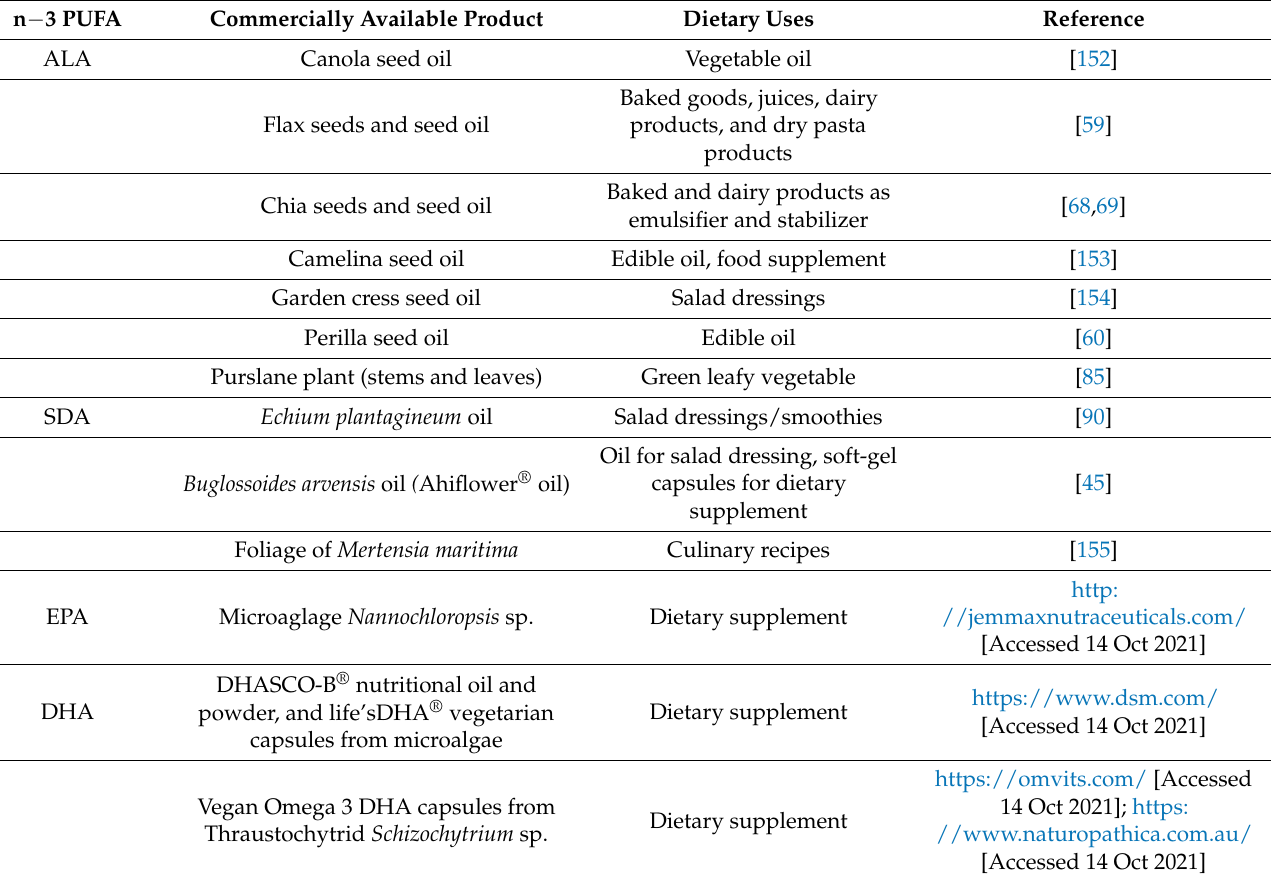
Table 3. The major commercially available vegan n − 3 PUFA-based dietary